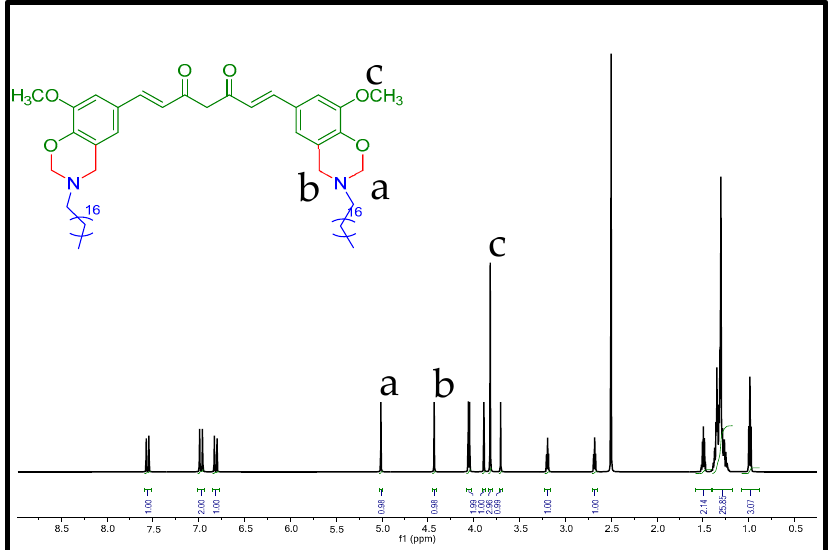
Figure 2. 1 H ‐ NMR spectrum of C ‐ st. Figure 2. 1 H-NMR spectrum of